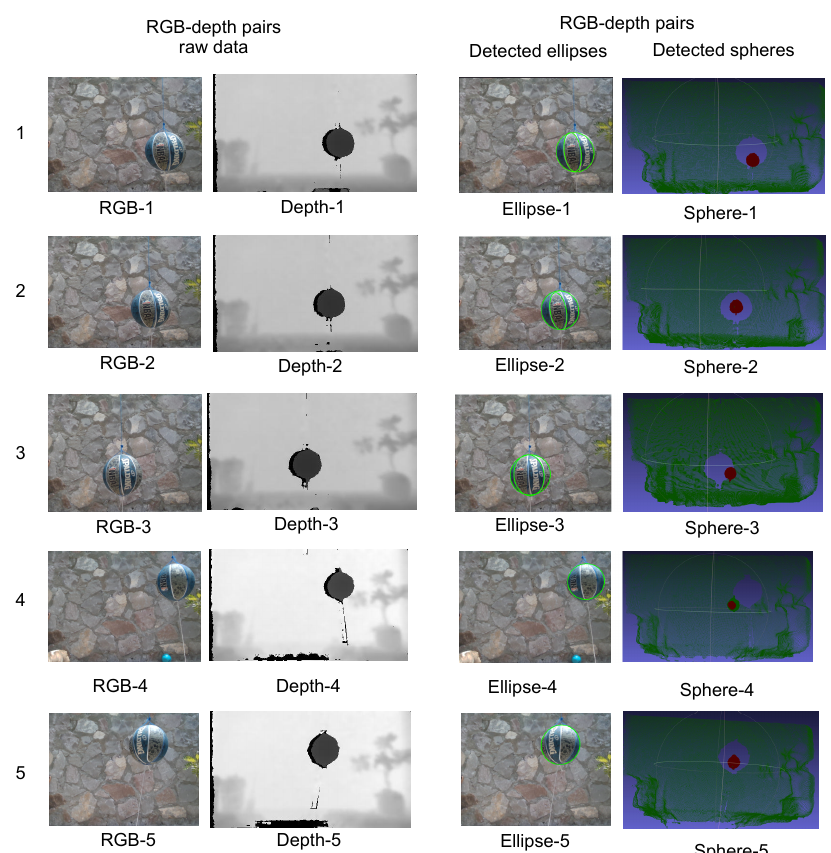
Figure 9. A set of five different images with a basketball visible in the scene is needed, images from 1 to 5 show the same scene with a basketball in 5 different positions, before ( left ) and after ( right ) detection of ellipse centers and spheres